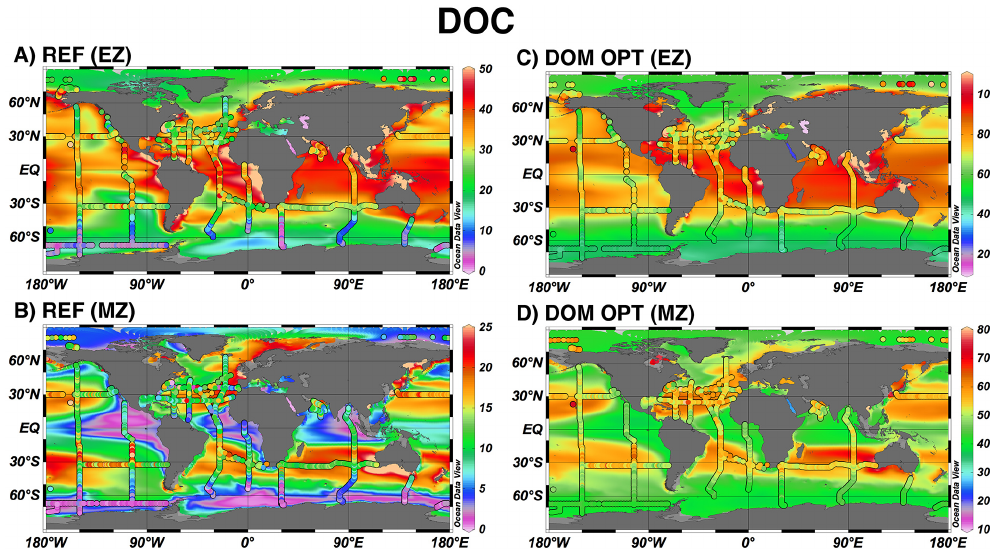
Figure 3. Plots of simulated semilabile [DOC] (µM; colored contours) with observations (colored dots) for the REF simulation at (a) the surface (EZ) and (b) 200m (MZ). Total [DOC] (µM; semilabile + refractory) for the DOM OPT simulation is shown for (c) the surface (EZ) and (d) 200m (MZ). Note the difference in color scales between plots (a) and (c) ; (b) and (d) as the REF simulation lacks a DOCr tracer.